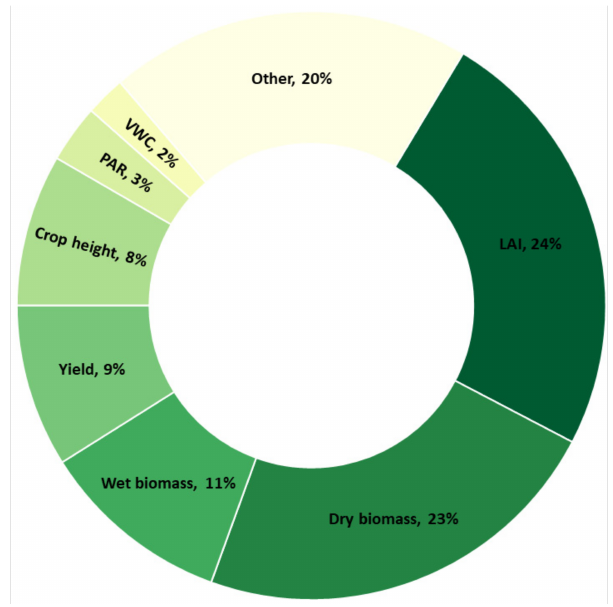
Figure 15. Most studied crop biophysical